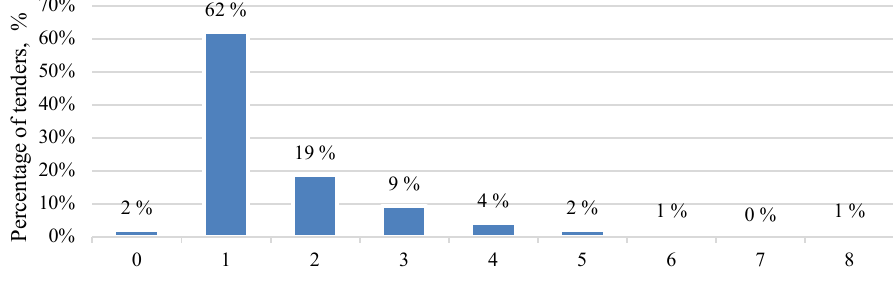
Fig. 1. Number of mandatory green criteria included in Latvian public tenders of food